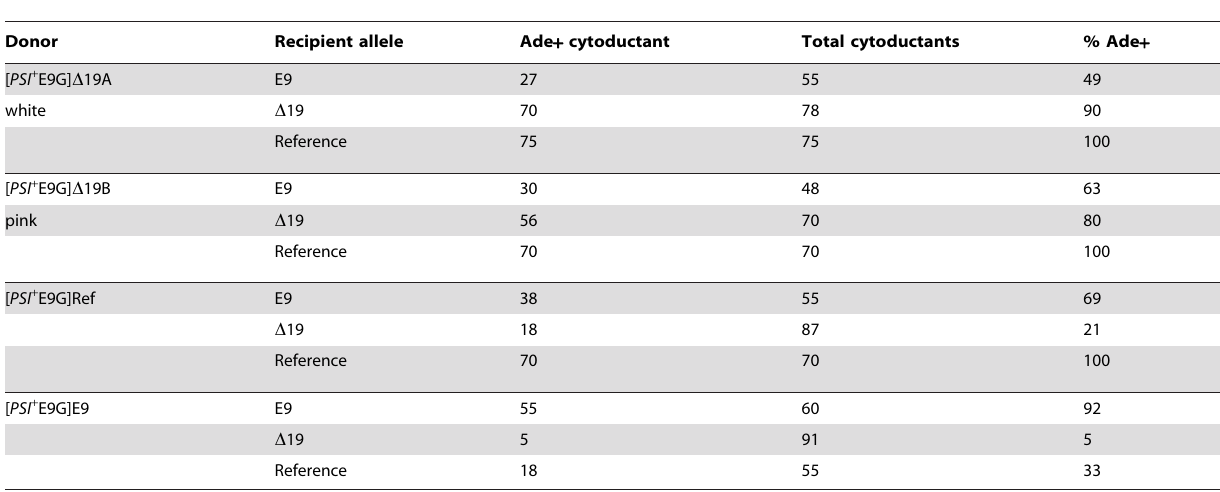
Table 2. Propagation characteristics of [ PSI + E9G] carried by different Sup35 polymorphs.